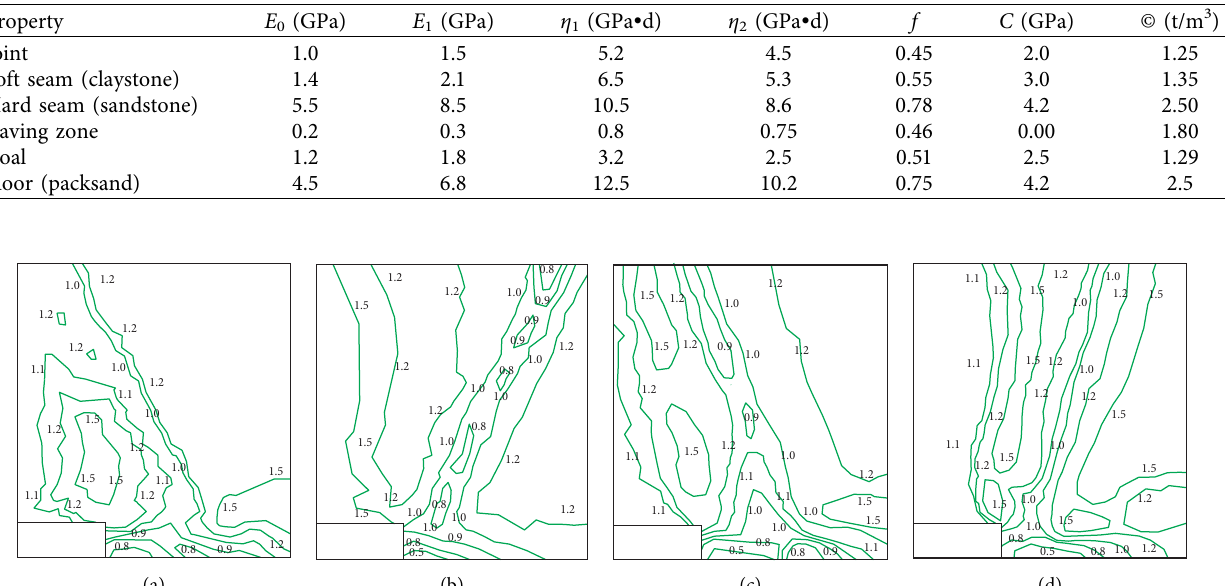
Table 1: The parameters of each stratum.